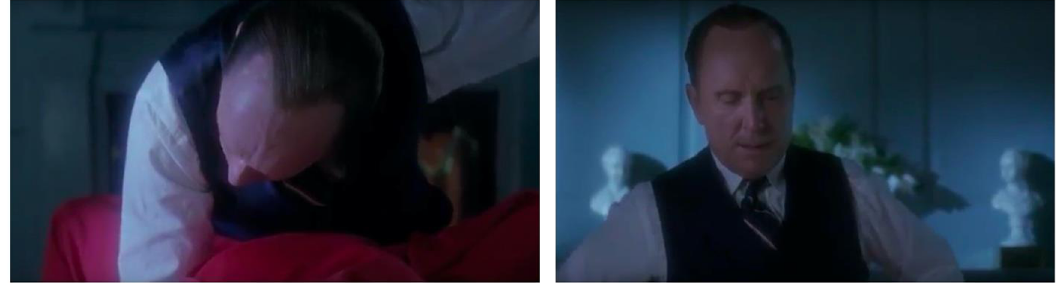
Figure 3: The Commander ( Robert Duvall ) at the Ceremony in Schlöndor ff ’ s The Handmaid ’ s Tale